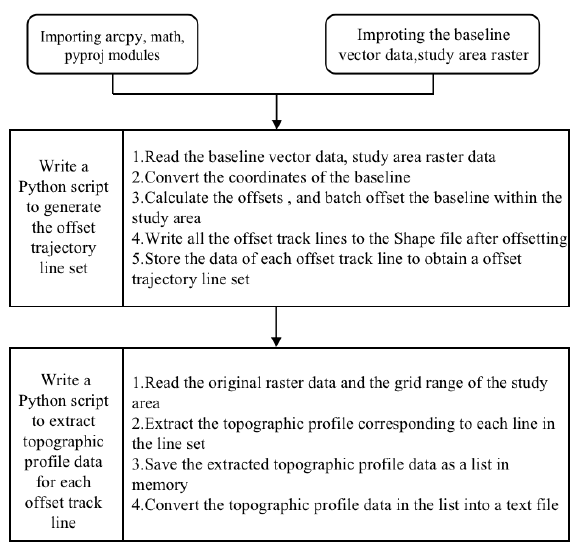
Figure 6. Technical roadmap for extracting the topographic profile.